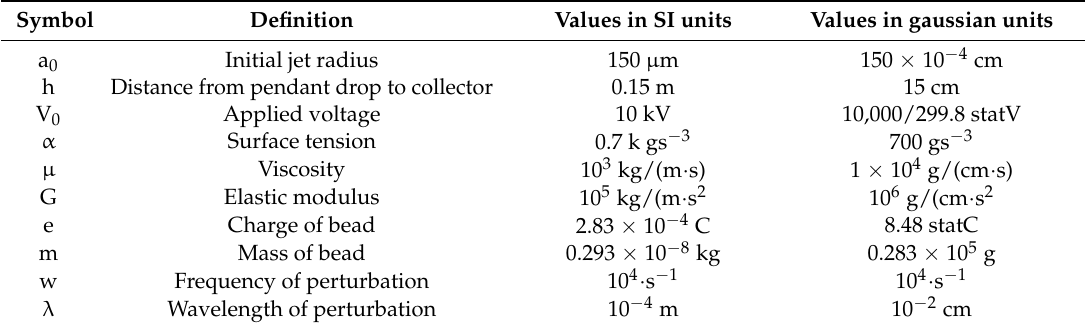
Table 3. Discrete bead model simulation Parameters [7,16].